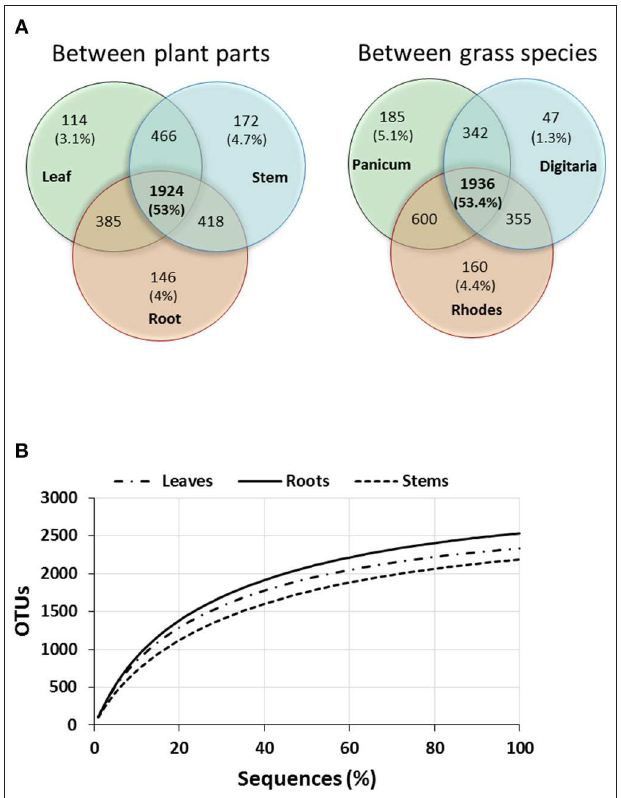
FIGURE 2 | Venn diagram showing number of unique and shared OTUs of total OTUs between different plant parts and grasses (A) and rarefaction curves of OTUs of NifH sequences (B) cumulatively obtained from the three plant parts (averages for the three perennial grass